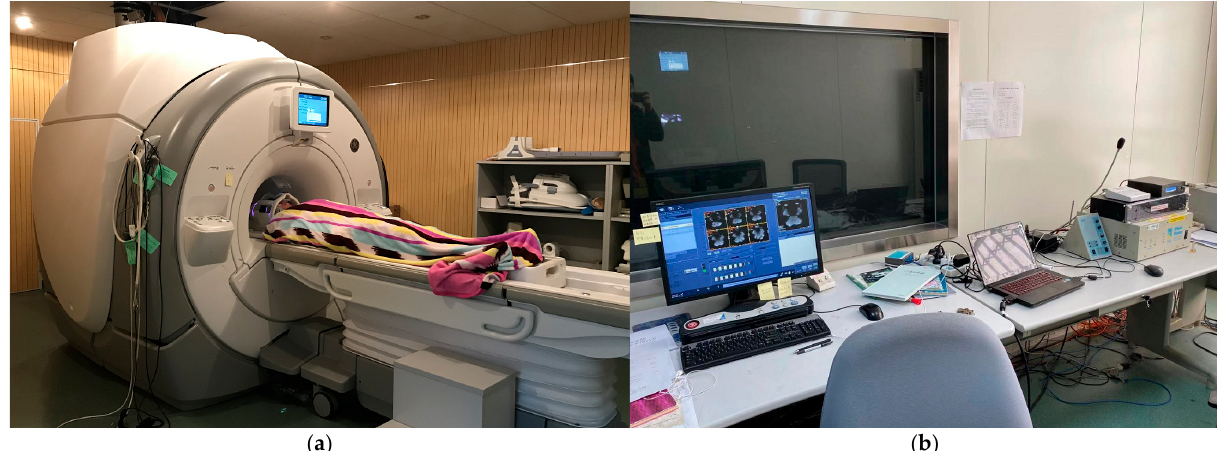
Figure 3. ( a ) fMRI instrument; ( b ) fMRI